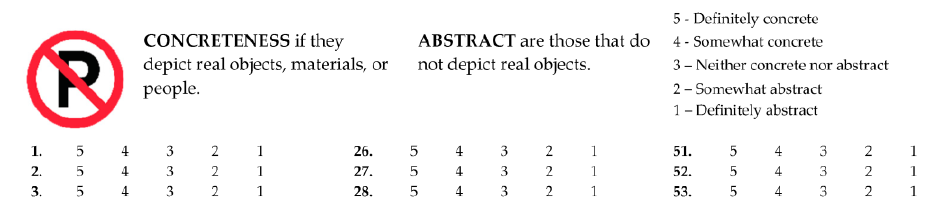
Figure 4. Sample evaluation sheet for cognitive design features.